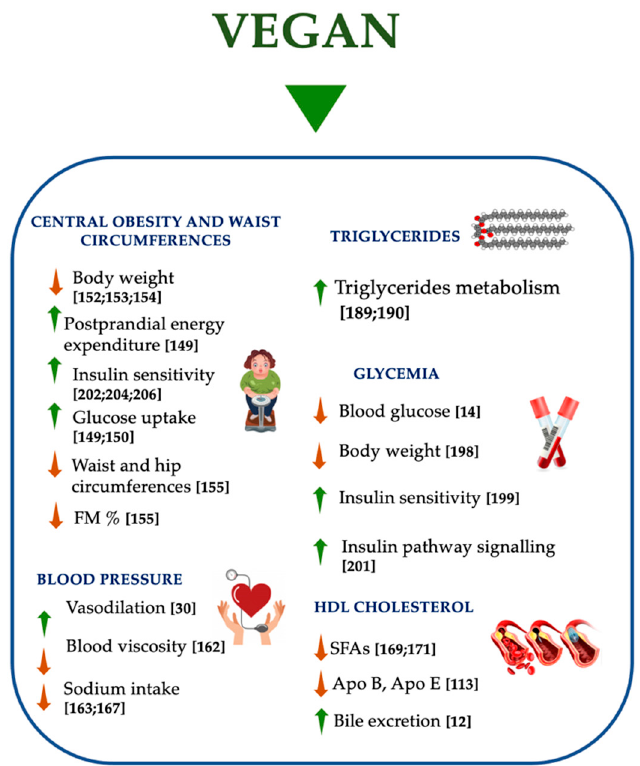
Figure 6. Effects of vegan diet on metabolic syndrome. APO, apolipoprotein; FM, fat mass; SFAs, saturated fatty acids; ↑ increase; ↓ decrease.